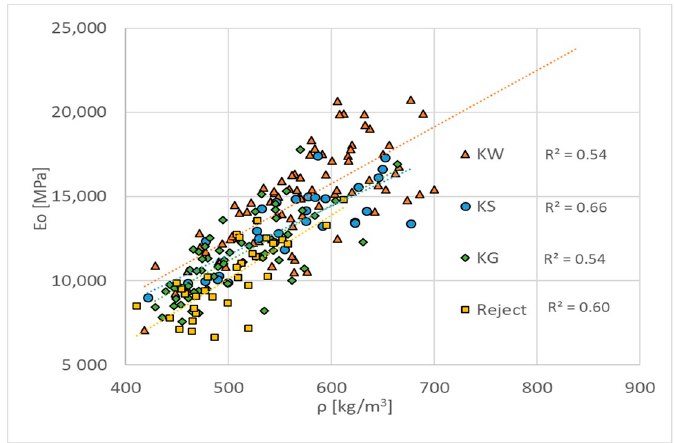
Figure 1. Correlations between the modulus of elasticity parallel to the grain and density, taking strength grades into account.